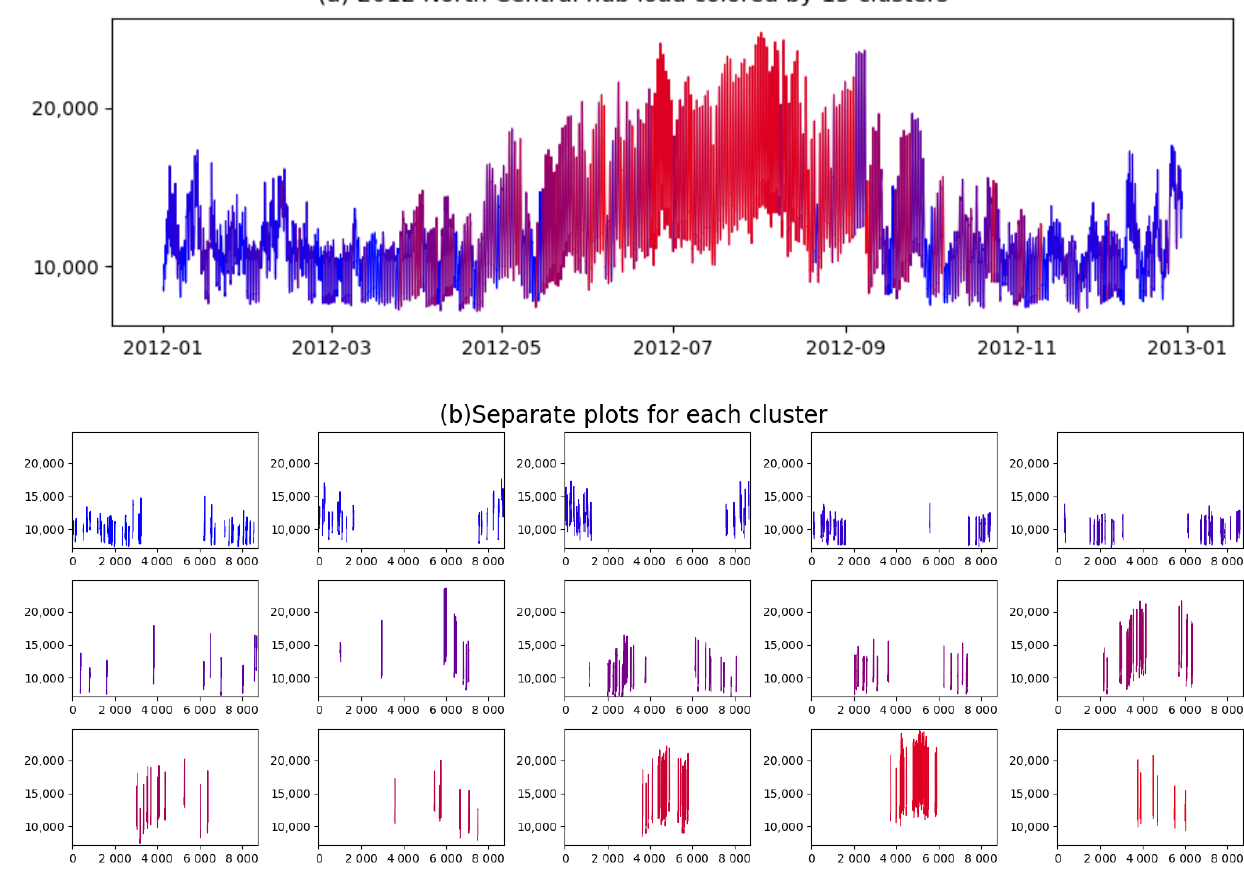
Figure 8. ( a ) 2012 North Central hub load colored by 15 clusters; ( b ) Separate plots for each